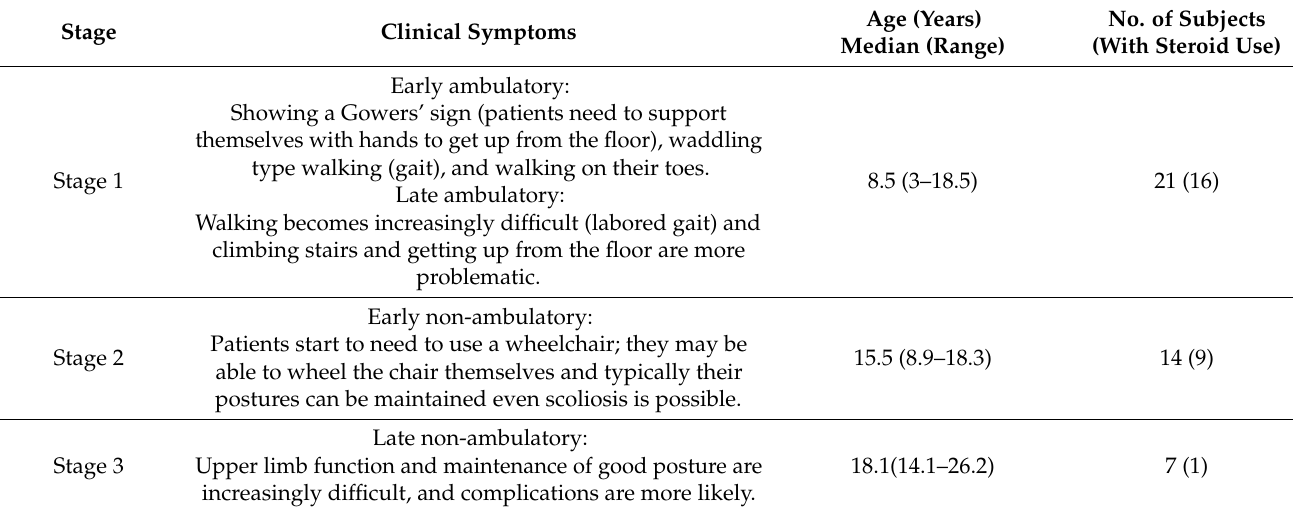
Table 1. The demographic data of the DMD patients at different ambulatory stages.